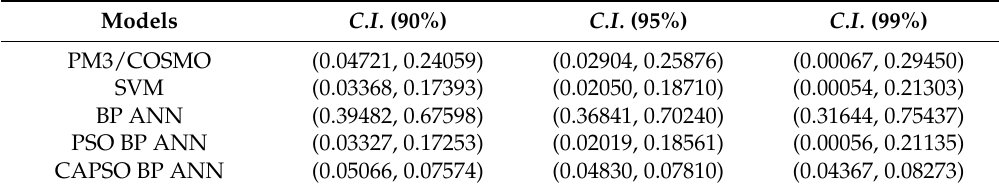
Table 6. Confidence intervals of RMSEP for each model. C.I. : Confidence